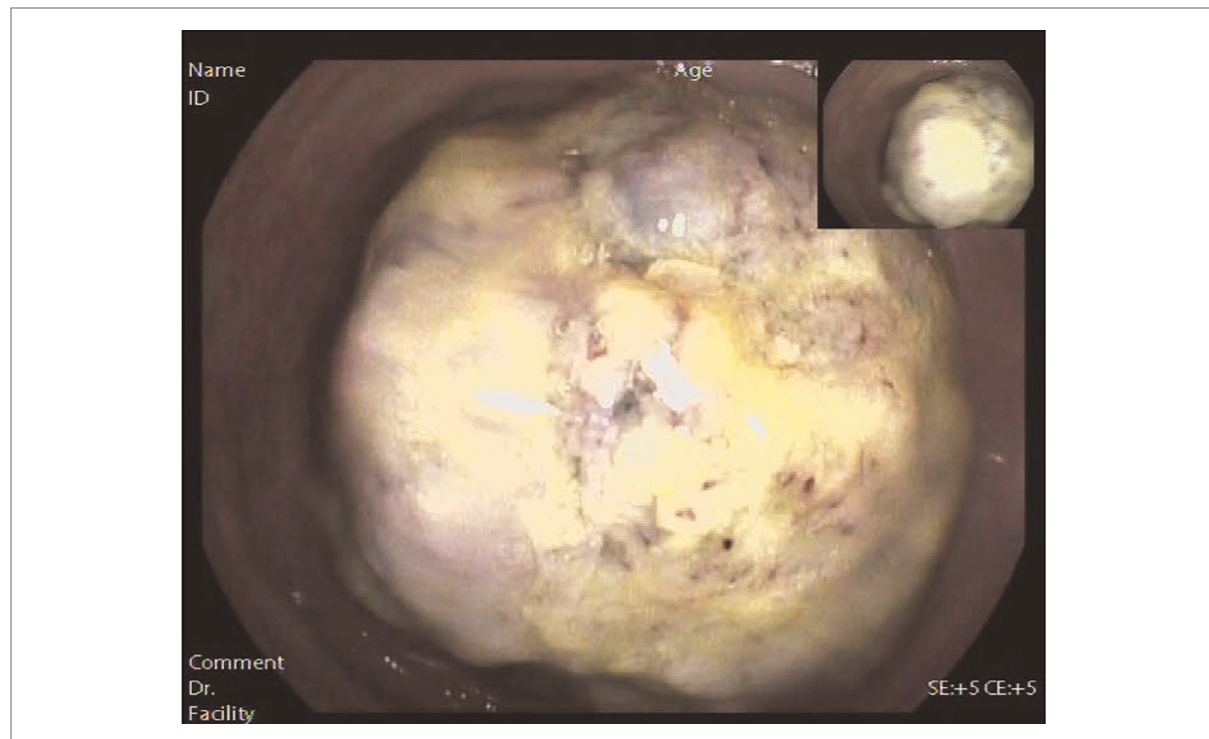
FIGURE 2 Electronic colonoscopy revealed a large proliferative lesion of the colon.